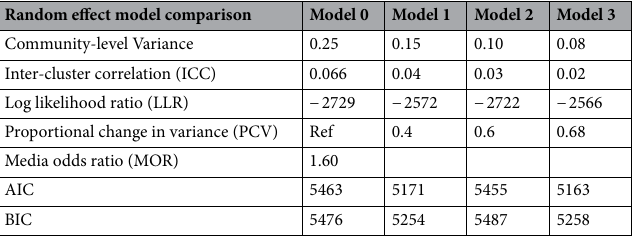
Table 4. Model comparison and random effect distribution of timely initiation of complementary feeding among children of 6–23 months age in Ethiopia, 2019